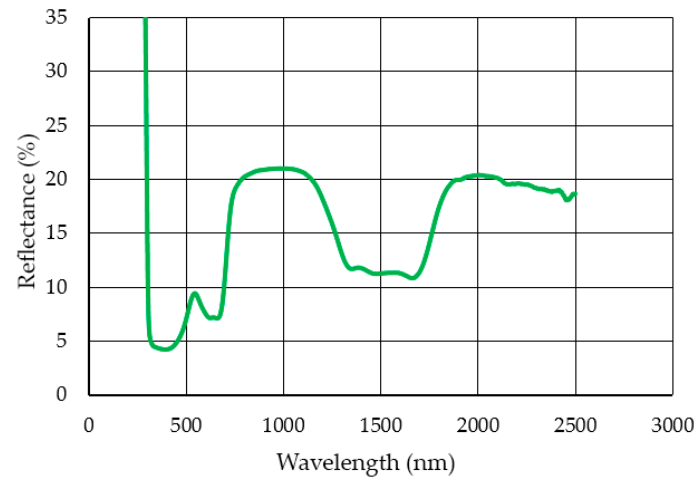
Figure 4. Reflectance values of the PFA coating.